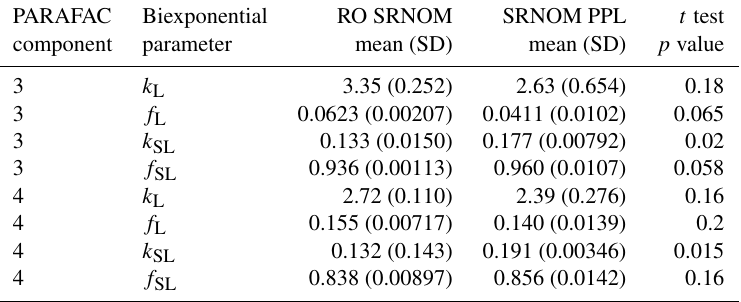
Table A1. Fitted biexponential model parameters (Eq. 3) for comparison between RO and PPL SRNOM. p values are from a two-sided t test of difference in means; n = 3 for both RO SRNOM and SRNOM PPL. f is unitless, and k is m 2 [molphotons] − 1 .